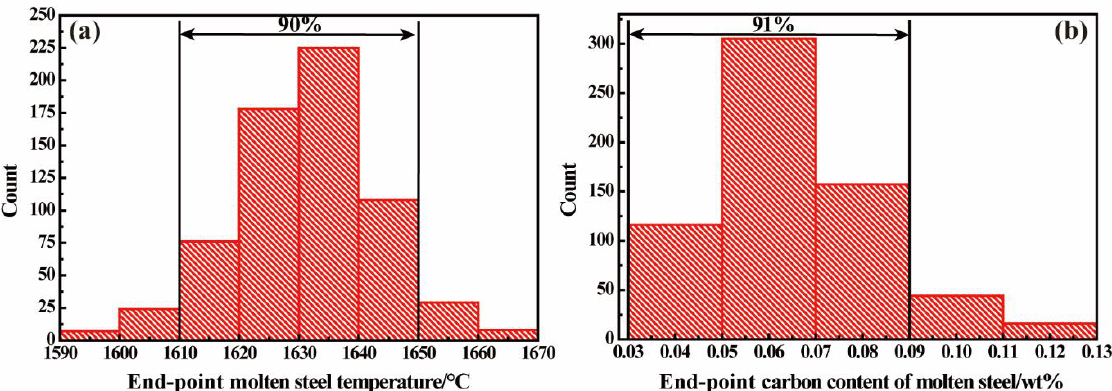
Figure 4. End-point molten steel conditions of 120 t converter.